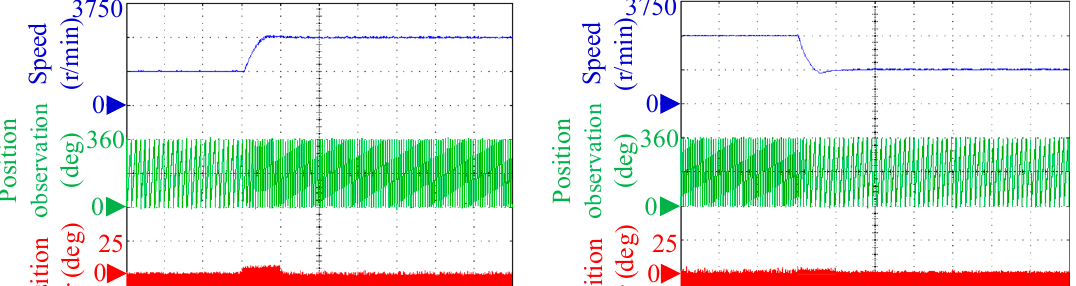
Figure 13. Experimental curves of speed response of STA-SMO.